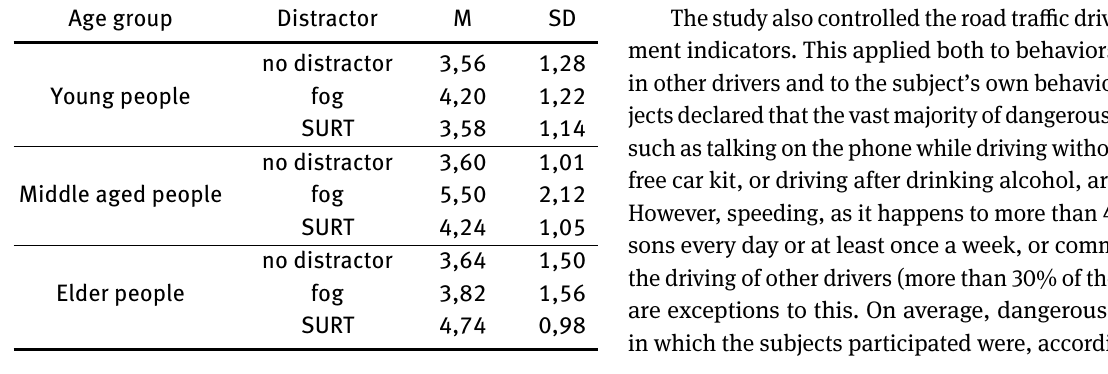
Table 3: Reaction times of drivers of different ages during driving without distractors, driving in fog, and driving with SURT, N = 95.